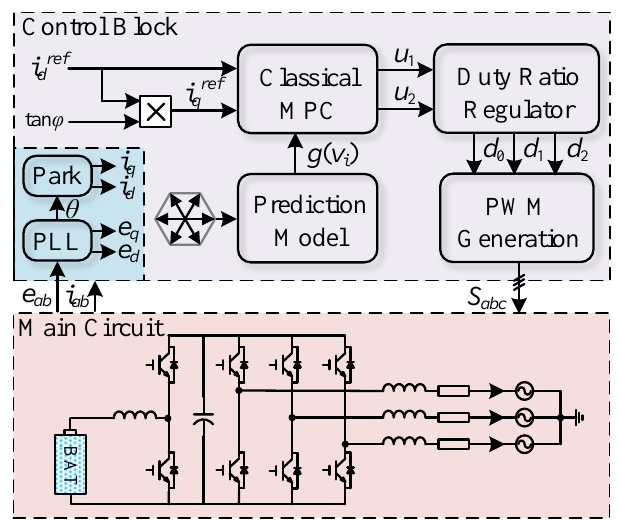
Figure 3. Control block of the proposed MPC method.